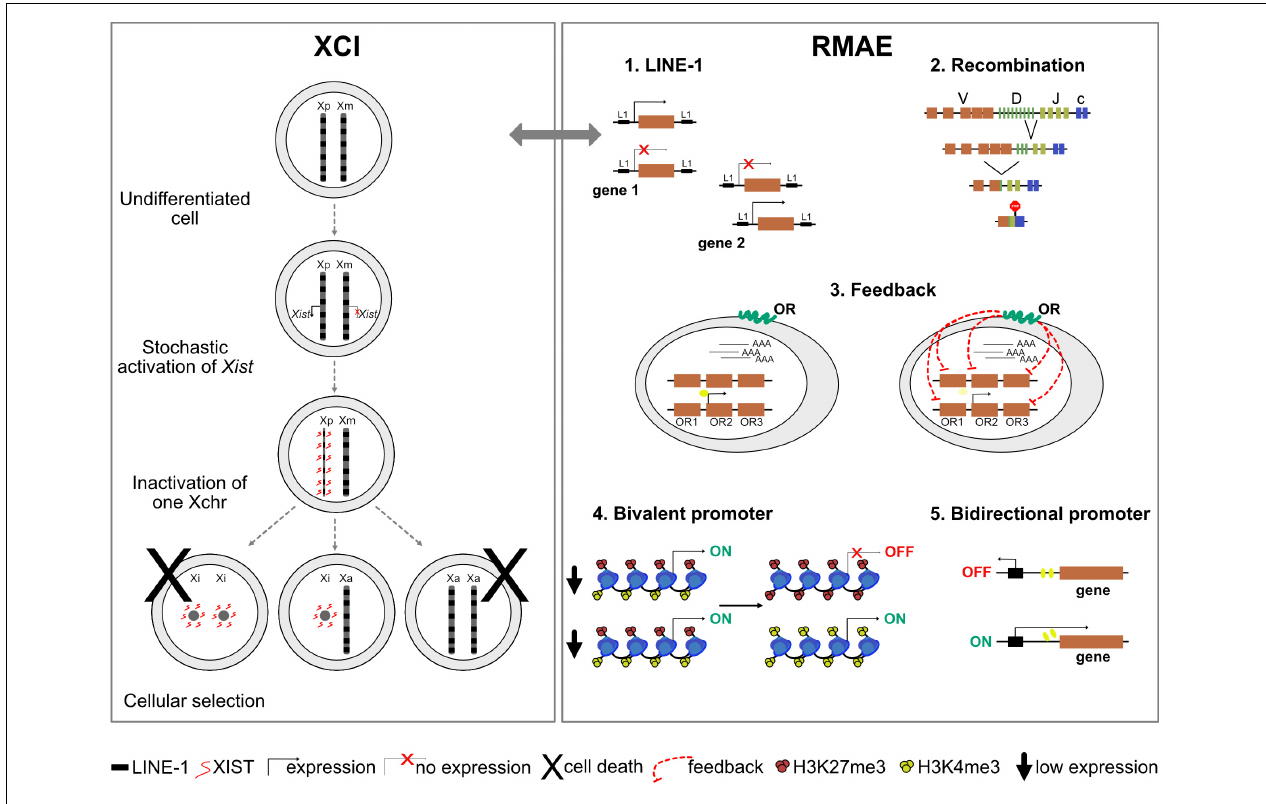
FIGURE 2 | A schematic representation of mechanisms responsible for X-chromosome inactivation (XCI) and mechanisms possibly responsible for random monoallelic autosomal expression (RMAE). The gray arrow represents a potential parallel between XCI and RMAE associated with LINE-1 (L1) elements.